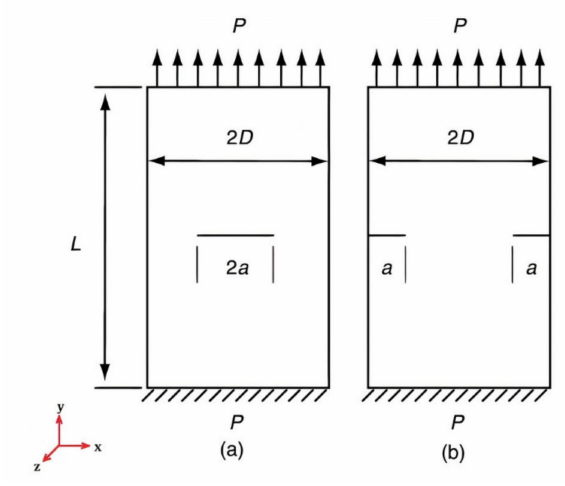
Figure 5. Specification of ( a ) center cracked specimen ( b ) double edge cracked specimen.